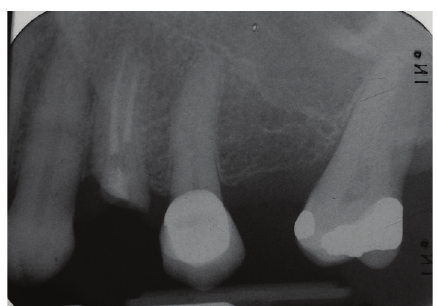
Figure 2: Periapical radiograph of UL4 shows intact root fillings, oblique fracture and a healthy root.